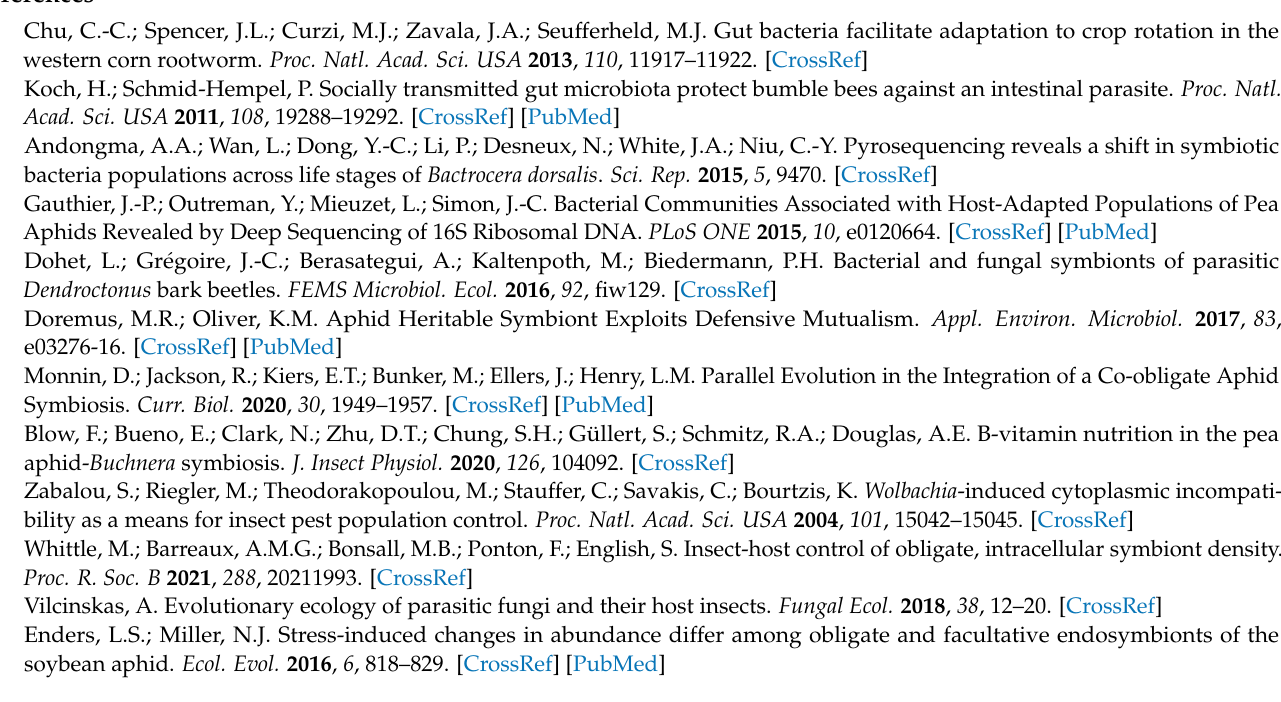
Figure S4: Relative composition of bacterial (A) and fungal (B) classes in aphid- related microbiomes under three different conditions. Figure S5: Relative compositions of different bacterial (A) and fungal (B) families under the three aphid